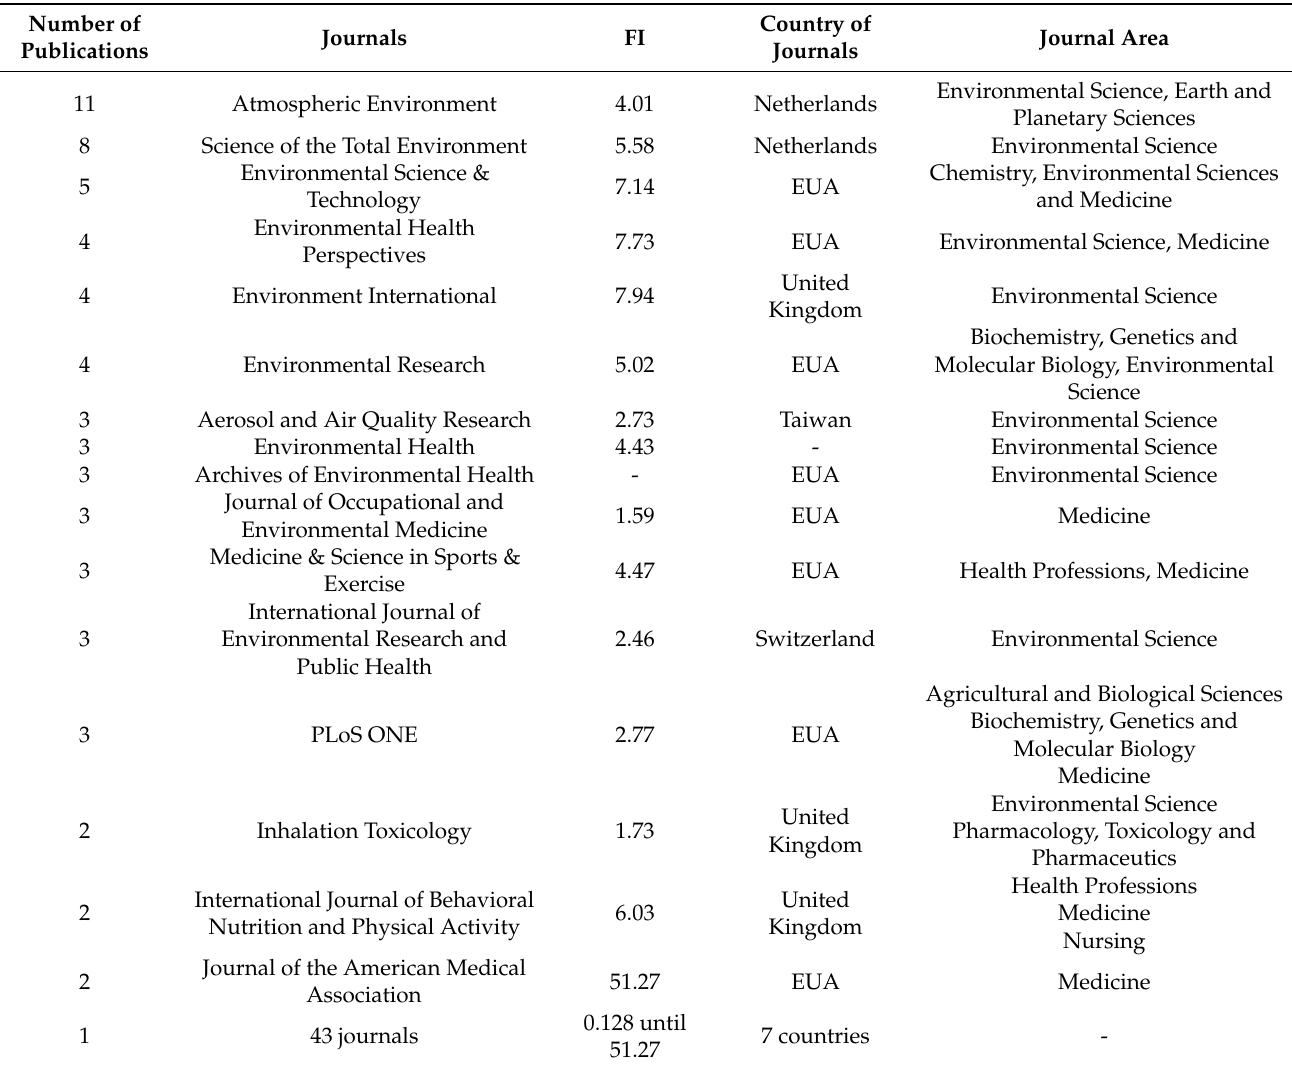
Table 5. The number of publications, impact factor, and country and area of the